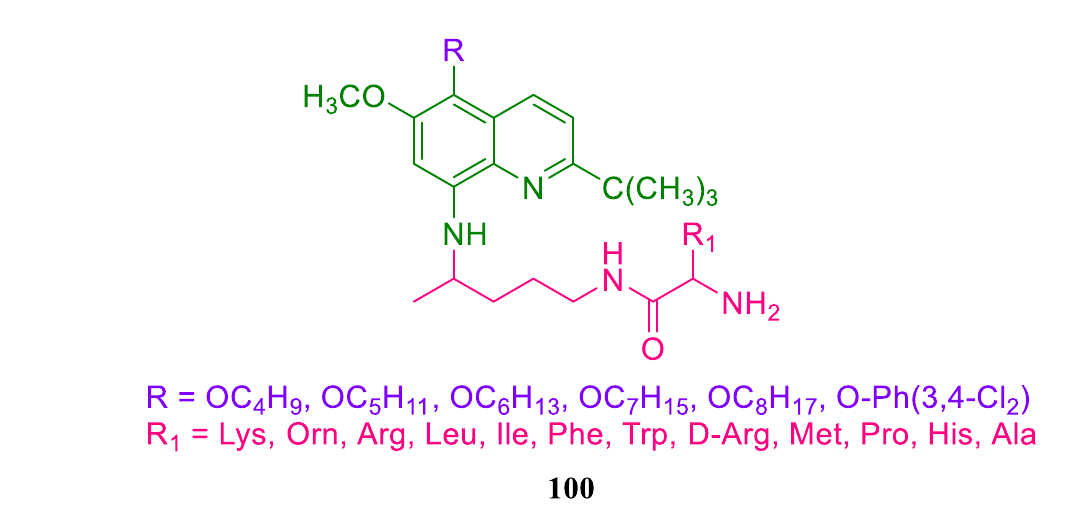
Figure 81. 8-quinolinamines conjugated to amino acids. Kumara H K et al. have synthesised dipeptides ( 101 , 102 ), i.e., KE, KD, KW, kE, kD and kW by coupling Boc-Lys(Z)-OH with HCl.H-Xaa-OPg (Xaa = Glu [OMe], Asp [OBzl] and Trp; Pg = OMe or OBzl) in the presence of NMM as base and IBCF/HOBt as coupling agent, followed by the saponification of the former product, which yielded peptides having free C-terminus end. The Cbz protecting group was deprotected by employing hydrogenolysis using 10% Pd/C, whereas Boc group was deprotected using TFA and reacted the E C and α C amino groups of Lys with quinazolinones, finally furnishing tetramers having various carbonyl-containing heterocyclic derivatives of piperazine, benzisoxazole and quinazolinone (Figure 82). The title compounds were evaluated for antimicrobial and anti- inflammatory activities. The antimicrobial activity was performed using agar-well diffusion and microdilution methods on different microbes, such as bacterial (Gram-negative ( E. coli ) and Gram-positive ( S. aureus )) and fungal strains ( A. niger and F. moniliforme )